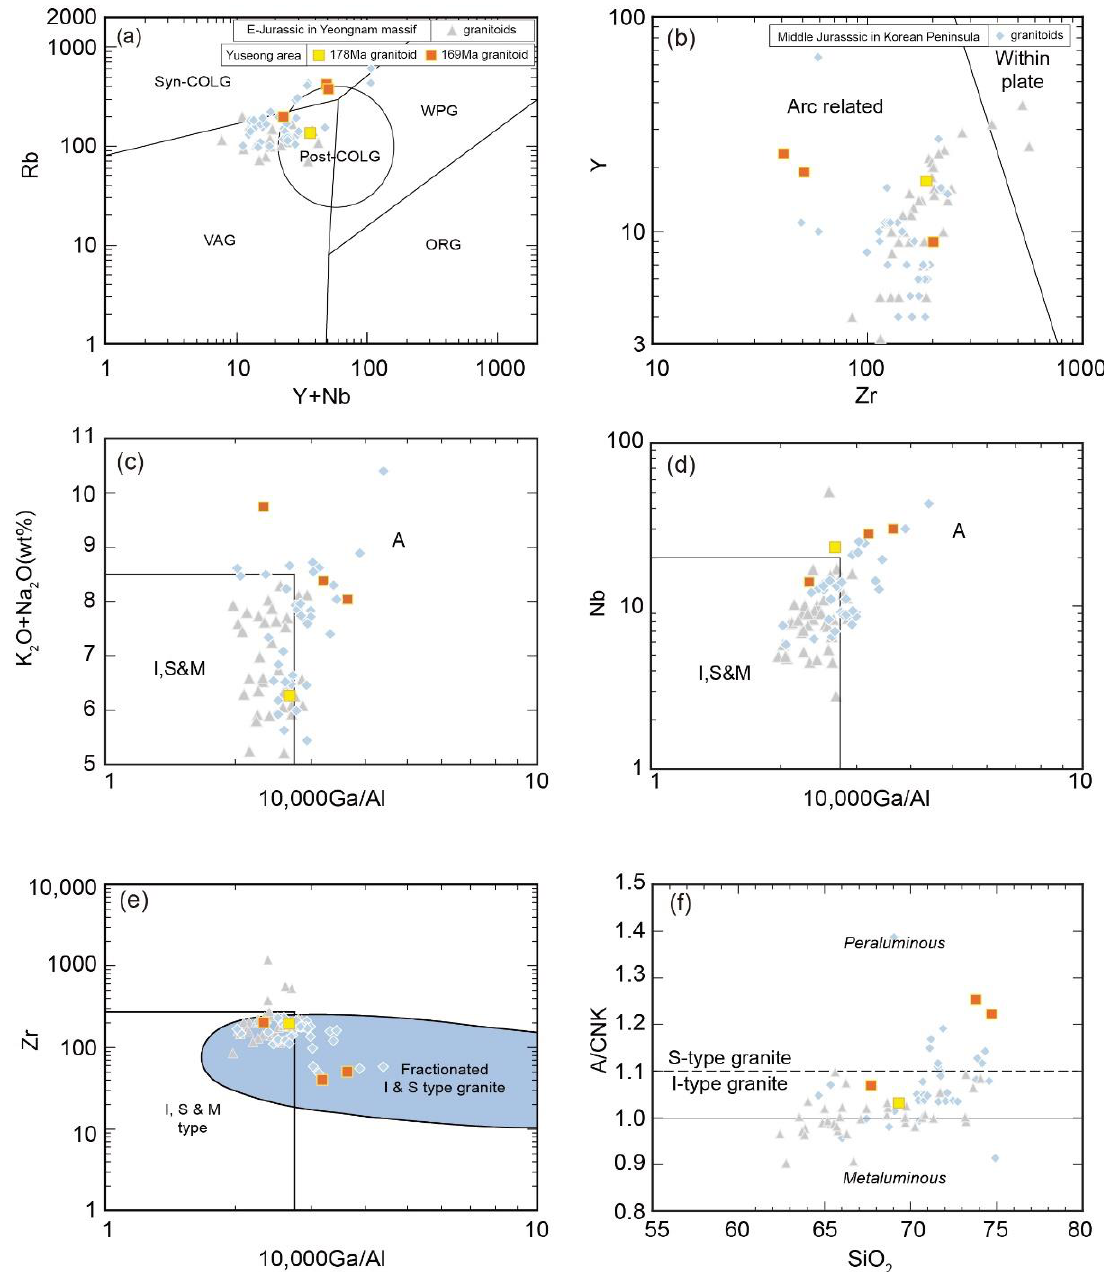
Figure 5. Binary plots for the Middle Jurassic granitoids in the Yuseong area and Early Jurassic granitoids in the YM in the ( a ) Rb vs. Y + Nb (after Pearce et al. [39]), ( b ) Y vs. Zr (after Müller et al. [40]), ( c ) K 2 O + Na 2 O vs. 10,000Ga/Al (after Whalen et al. [41]), ( d ) Nb vs. 10,000Ga/Al (after Whalen et al. [41]), ( e ) Zr vs. 10,000Ga/Al (after Wu et al. [42]), and ( f ) A/CNK vs. SiO 2 (after Maniar and Piccoli [36]) diagrams. Data sources of Middle Jurassic granitoids in Korean Peninsula from Kim et al. (2015) [3] and references